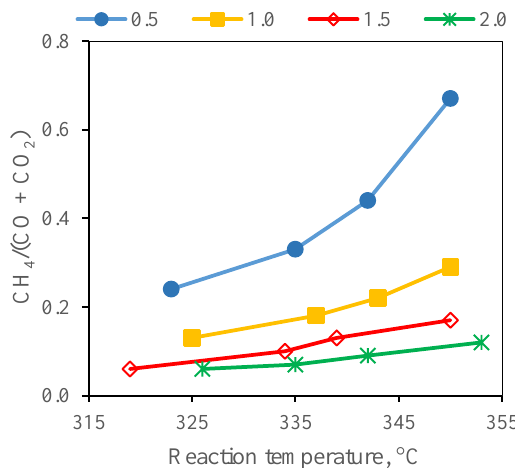
Figure 5. Methane to (CO + CO 2 ) ratio at WHSV of 0.5–2.0 h −1 . The shares of the HDO, HDCx and HDCn reactions in the RO conversion ( A HDO , A HDCx and A HDCn , respectively) are shown in Table 9. The hydrogen consumption for individual reactions together with the total hydrogen consumption and hydrogen excess are summarised in Table 10. The share of the HDCn reaction in the RO conversion